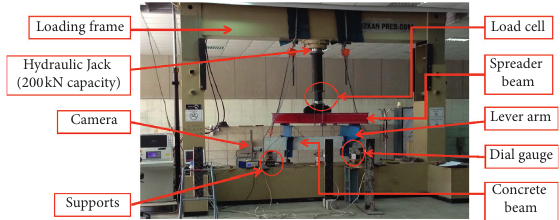
Figure 7: Test set-up with the loading frame.